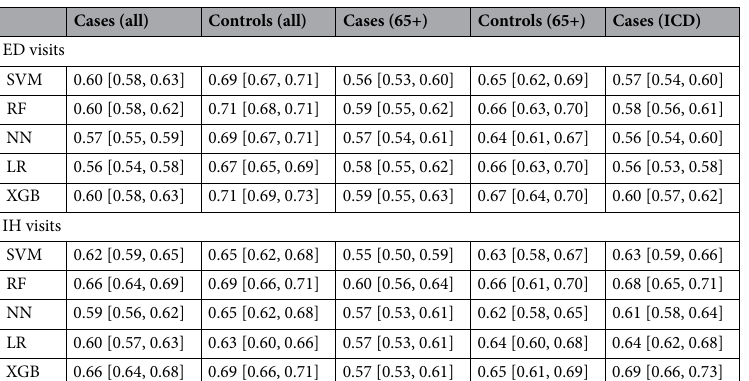
Table 4. Intra-cohort evaluation: AUC and 95% confidence interval of test samples for models trained on sociodemographic variables (So).